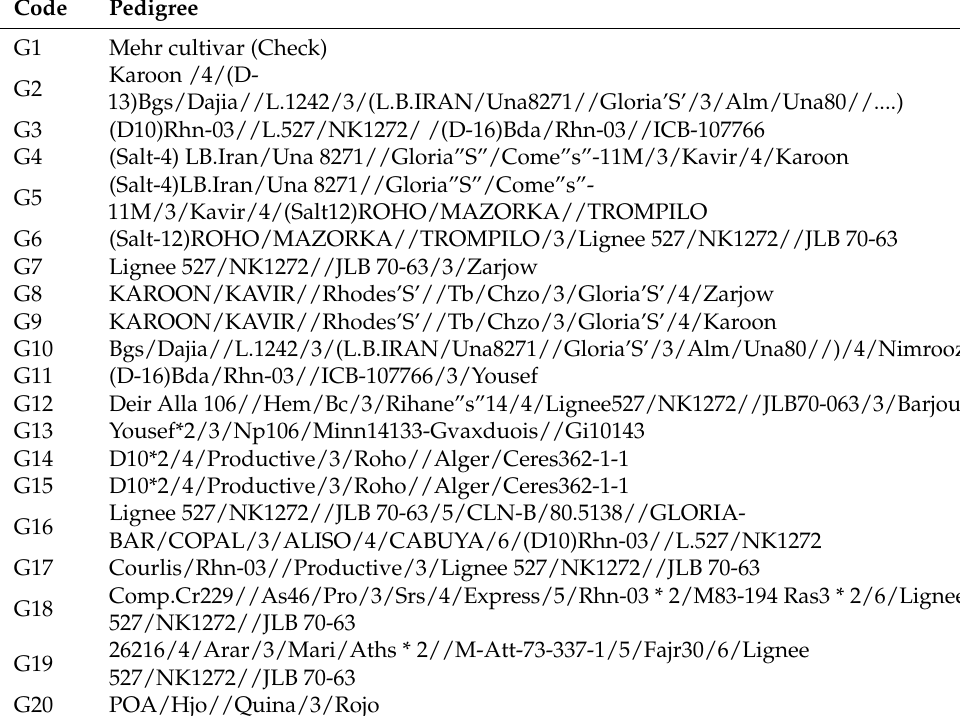
Table 1. The pedigrees of the 20 investigated barley